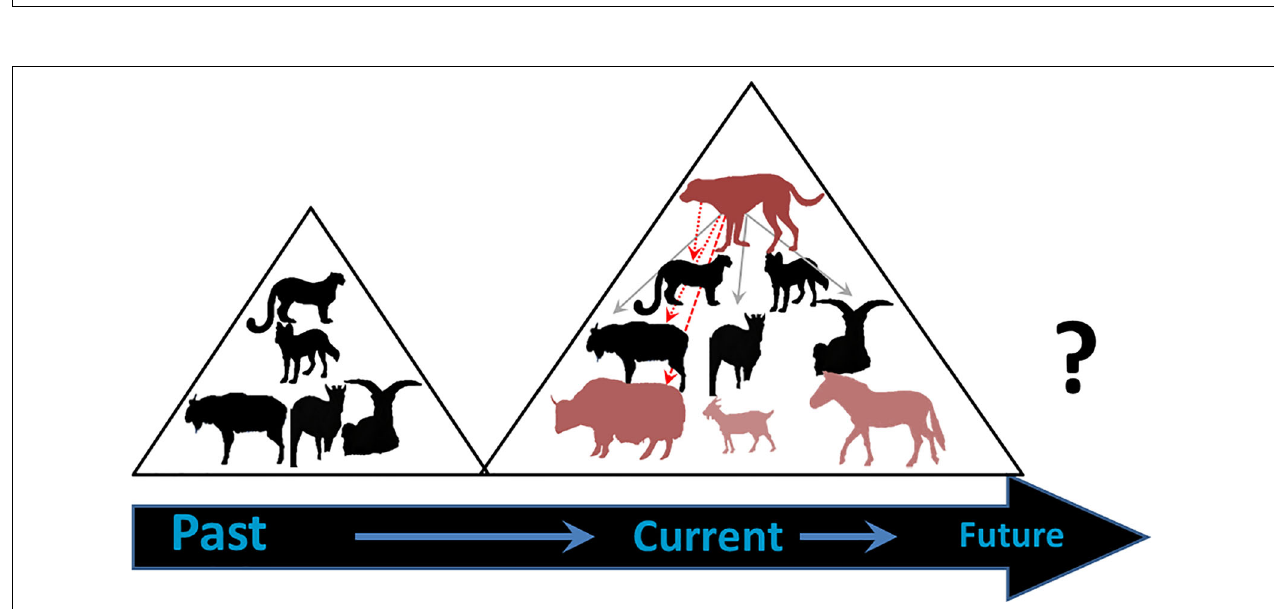
FIGURE 7 | Schematic overview of changes in a high-elevation Himalayan food web before and after pastoralism; this case study is from Bhutan’s Jigme Dorji National Park (JDNP). The black icons represent native species, from top to bottom–snow leopard, dhole, takin, goral, blue sheep; the faded icons are sympatric domestics–dogs, yaks, goats ∗ , horses. ( ∗ The goats are not in JDNP but exist in other parts of the Himalayas).